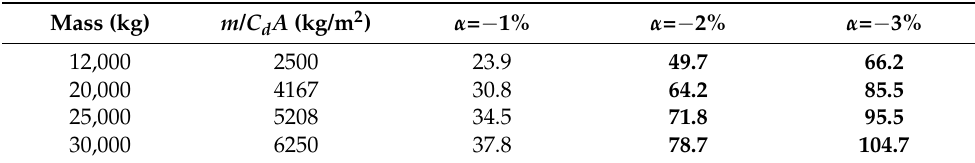
Table 3. Coasting speeds (mph) of trucks with different m / C d A in a platoon.